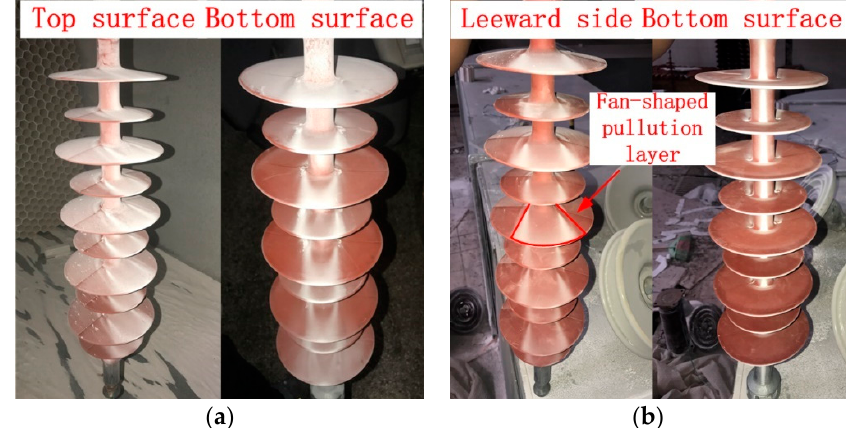
Figure 7. The contamination distribution of different insulators. ( a ) Sample in non-energized condition; ( b ) Sample with voltage of DC + 35 kV.